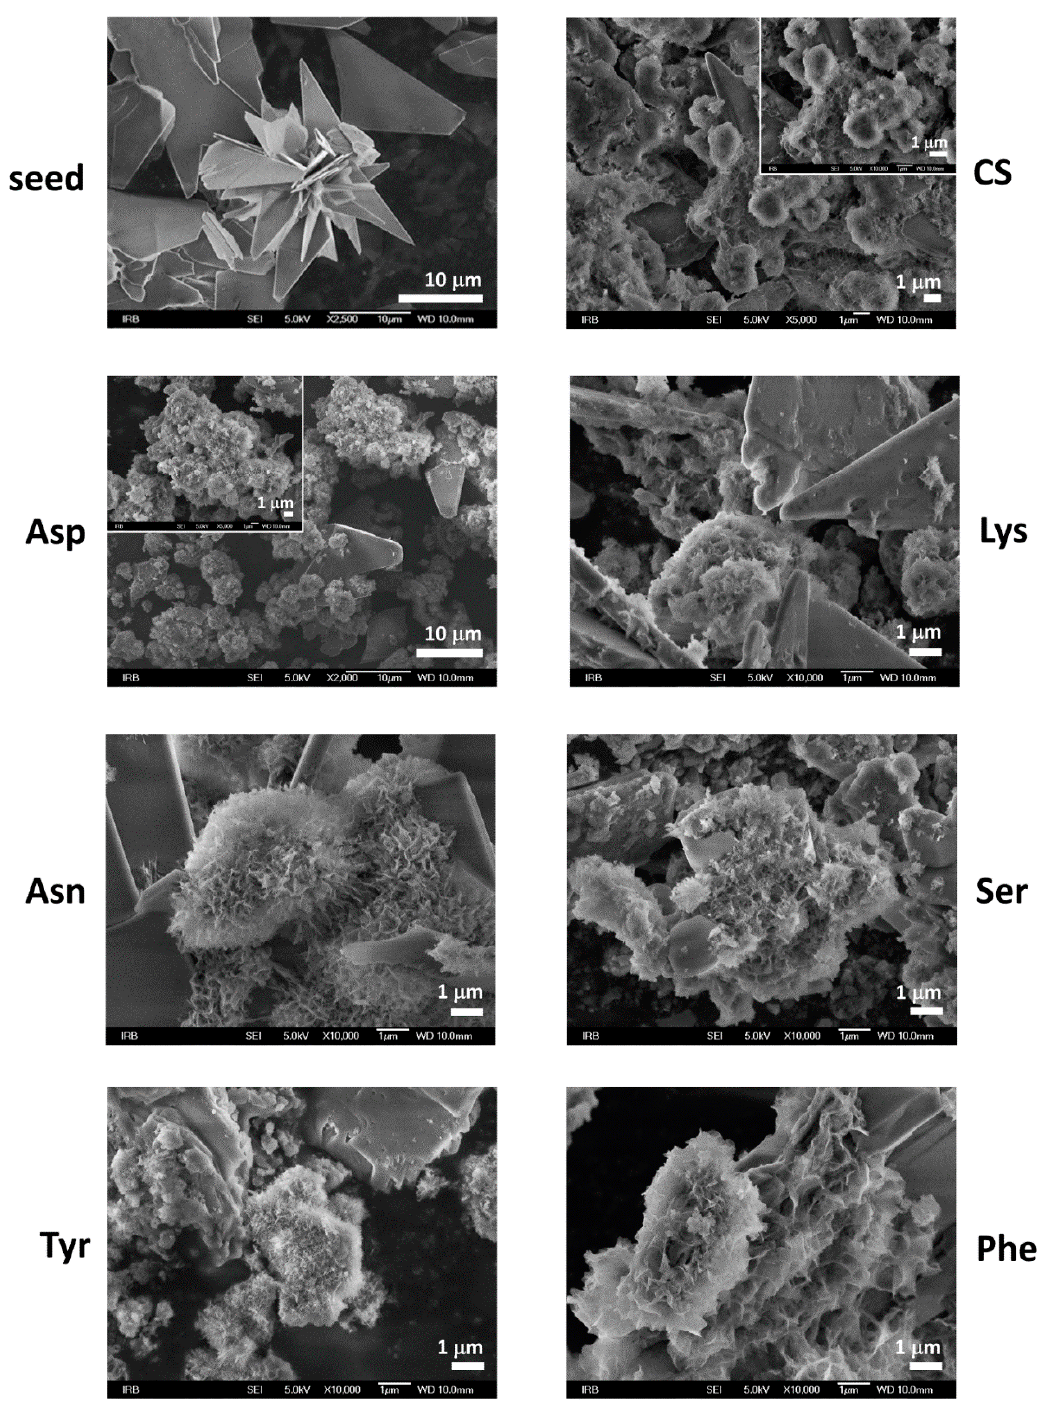
Figure 6. SEM micrographs of calcium hydrogenphosphate dihydrate (DCPD) seed crystals as well as precipitates formed in the control system (CS) and in the presence of different amino acids after 60 min aging time in the system c (CaCl 2 ) = c (Na 2 HPO 4 ) = 4.198 mmol dm − 3 , c (NaCl) = 0.148 mol dm − 3 , m (seed DCPD) = 1 mg, γ (AA) = 10 ppm, except γ (Phe) = 5 ppm. t = 25 °C, pH initial = 7.4, magnetic stirring. Asp—L-aspartic acid, Tyr—L-tyrosine, Asn—L-asparagine, Lys—L-lysine, Ser—L-serine, Phe— − phenylalanine.